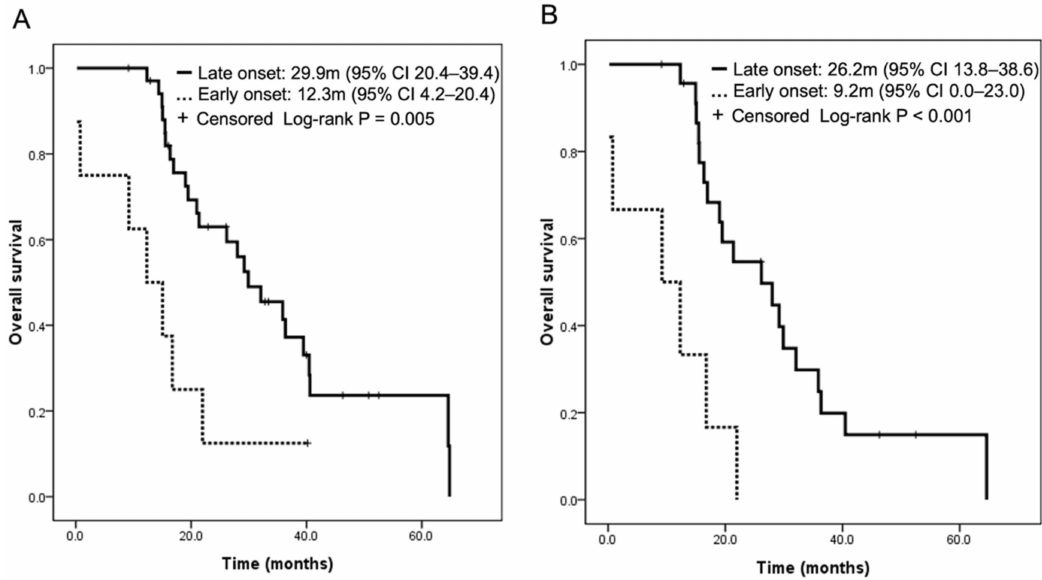
Figure 3. The onset of leptomeningeal metastasis and overall survival of EGFR-TKI treatment: overall population ( A ) and those without third-generation EGFR-TKI treatment ( B